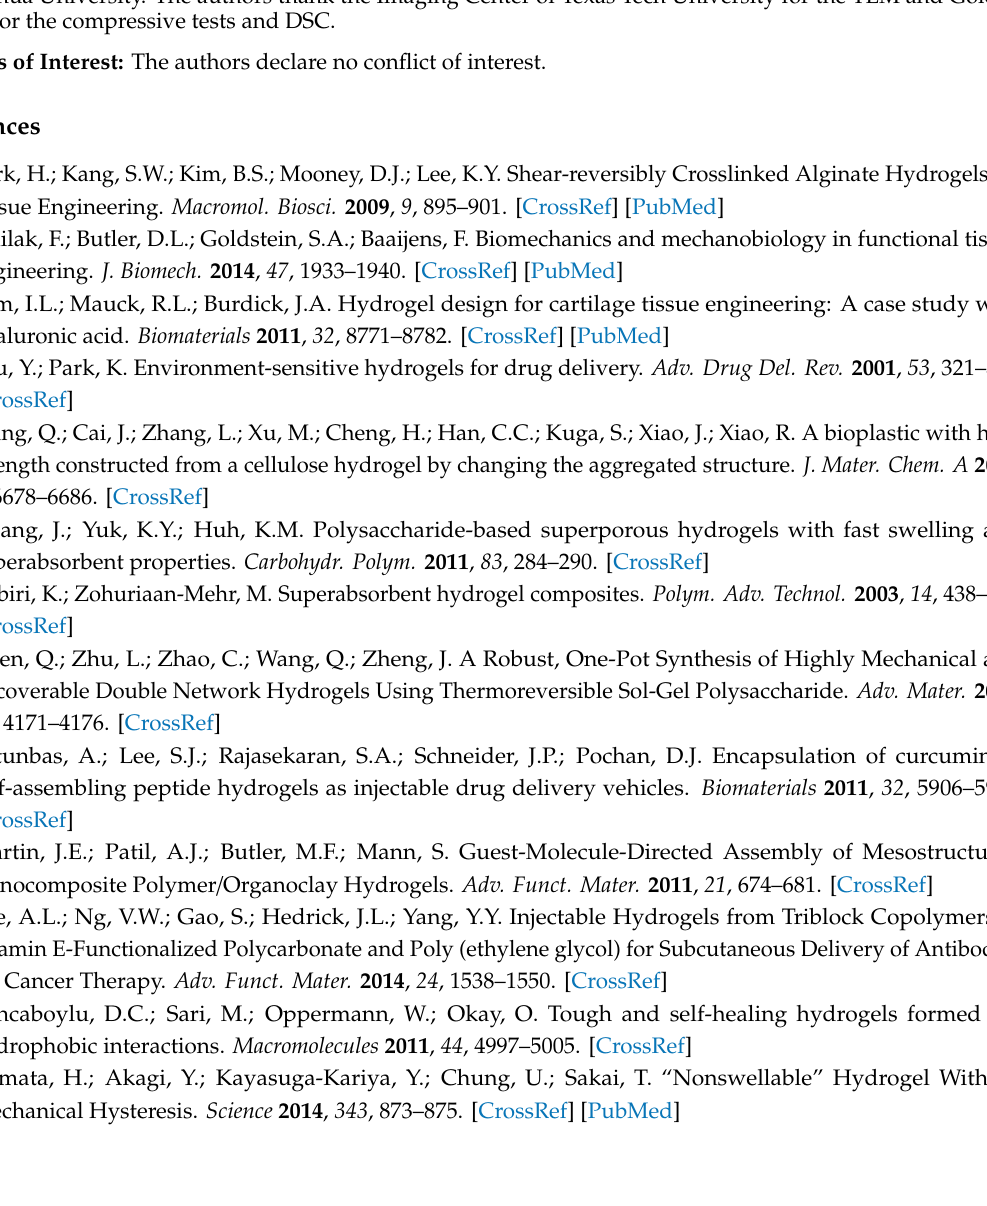
Figure S1: Zeta potential of (a) GO and (b) PGO, Figure S2: Representative cyclic loading − unloading curves of (a) DN and (b) PDN hydrogels for up to five cycles at 30% and 60% strain compression, Figure S3: DSC curves of carrageen, Table S1: Compressive properties of tough hydrogels with a maximum strain at 99%, Table S2: Compressive Properties of tough hydrogels with di ff erent strain, Table S3: Cyclic compressive properties of tough hydrogel with di ff erent